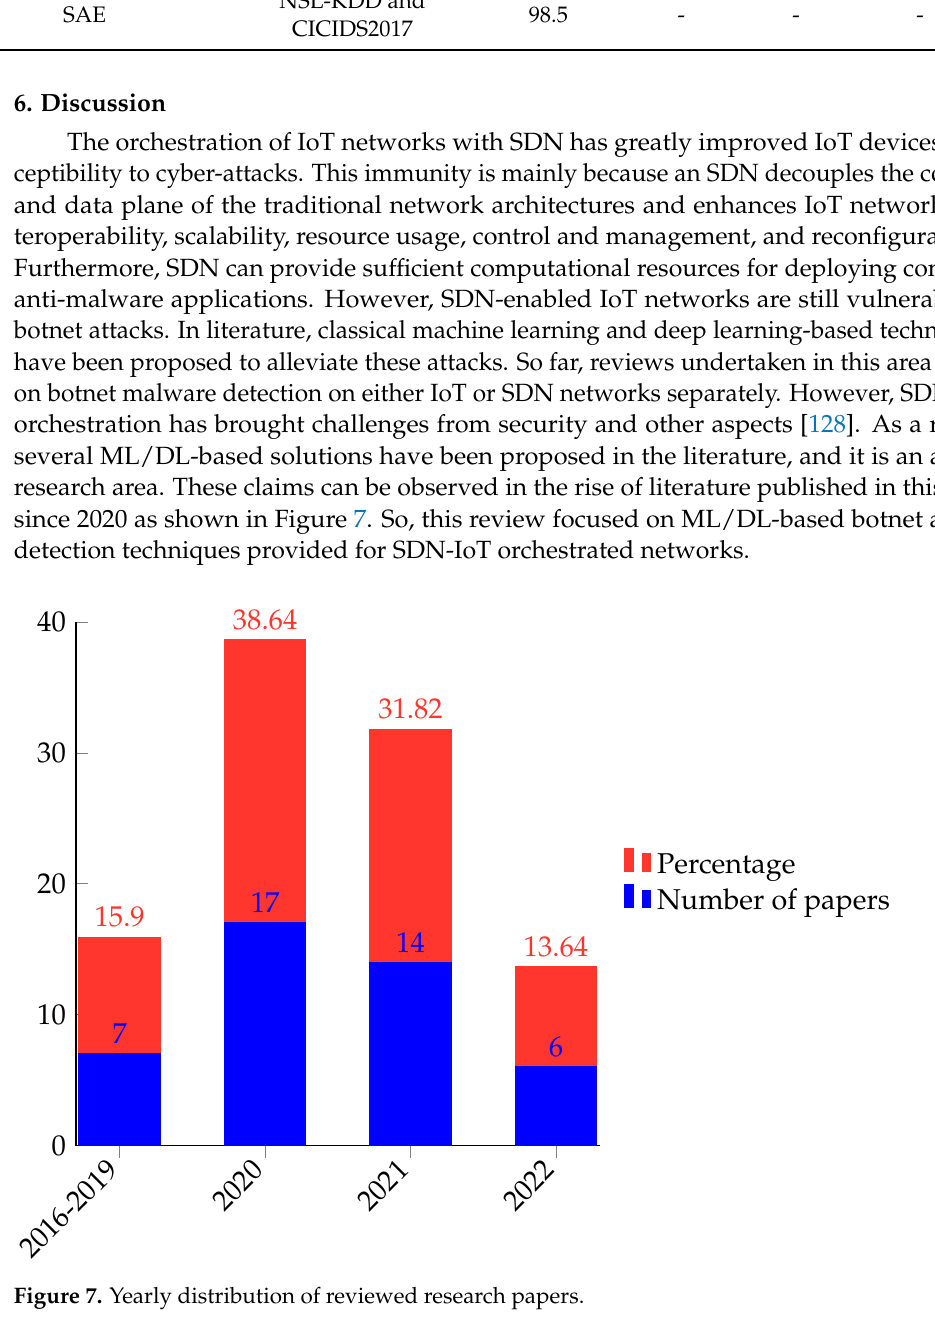
fectiveness in botnet attack detection as shown by their performance in Table 4. However, these techniques are highly dependent on extensive feature engineering. As a result, they